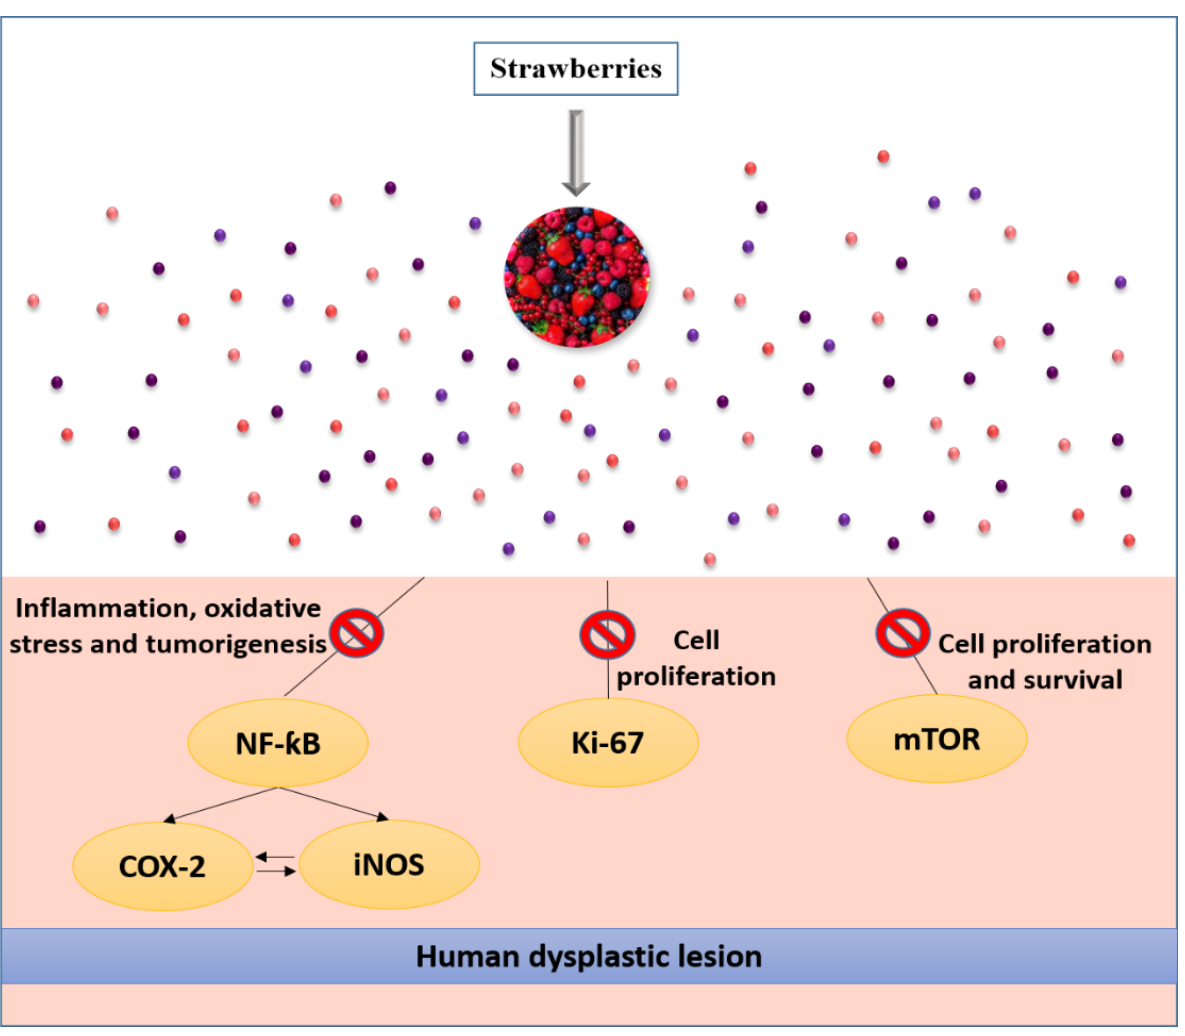
Figure 5. Inhibition mechanisms of esophageal precancerous progression by strawberries.